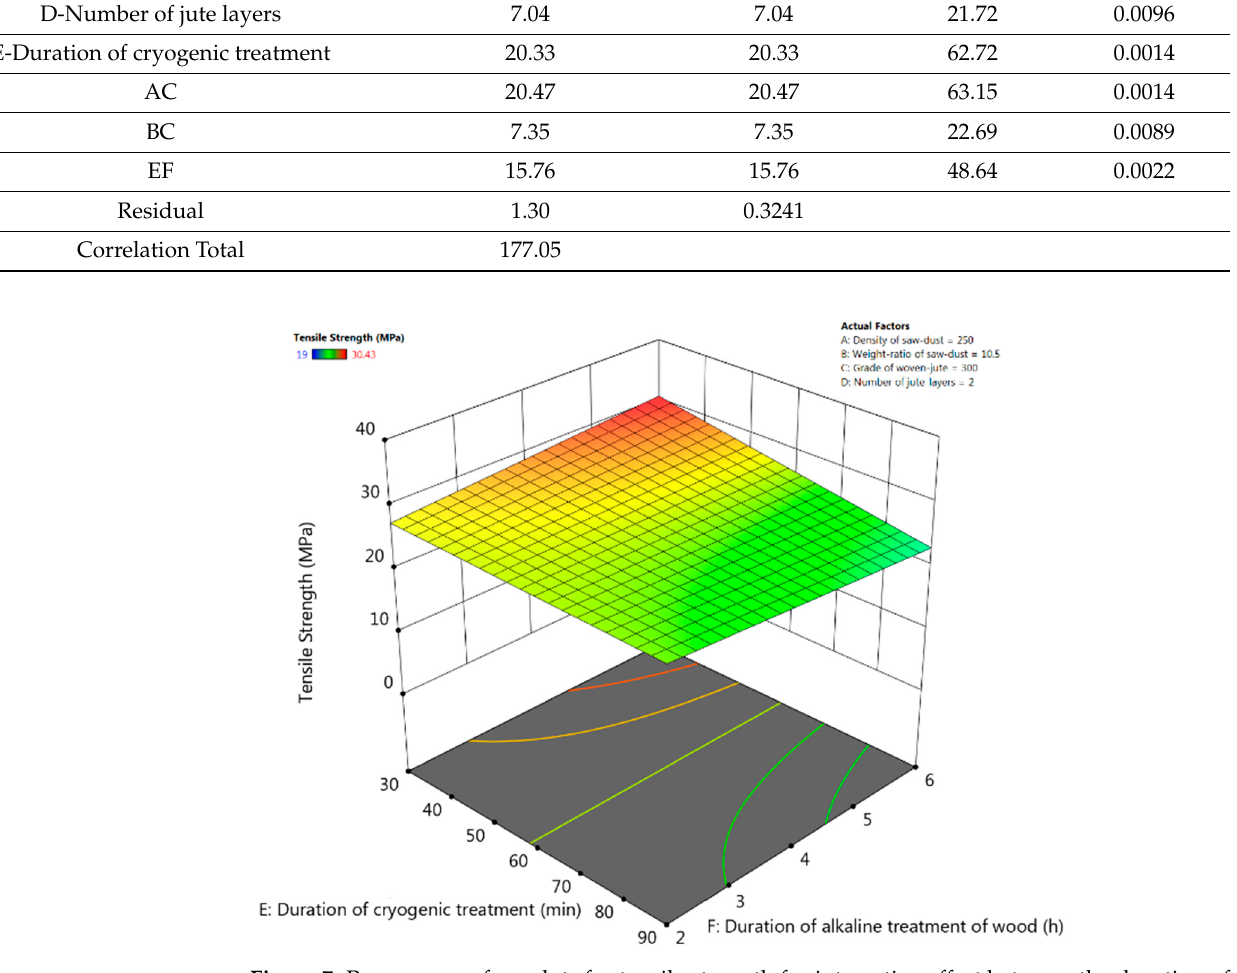
Figure 7. Response-surface plots for tensile strength for interactive effect between the duration of alkaline treatment and the duration of cryogenic treatment of composite.